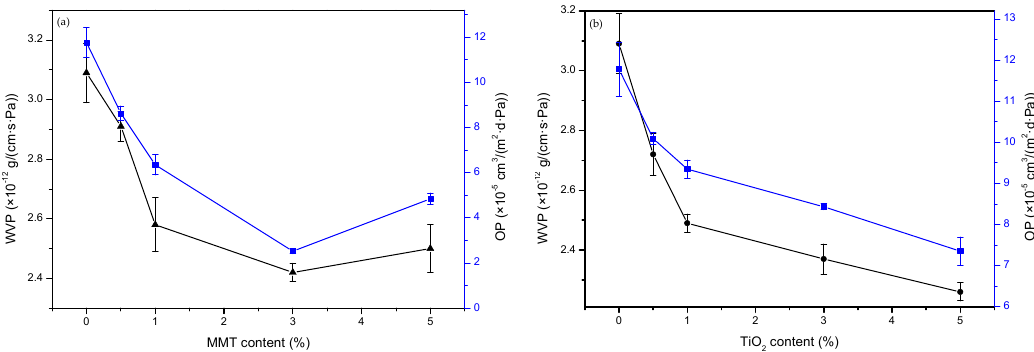
Figure 8. Water vapor permeability (WVP) and oxygen permeability (OP) values of ( a ) P‐40‐25 incorporated with MMT and ( b ) P‐40‐25 incorporated with TiO 2 .